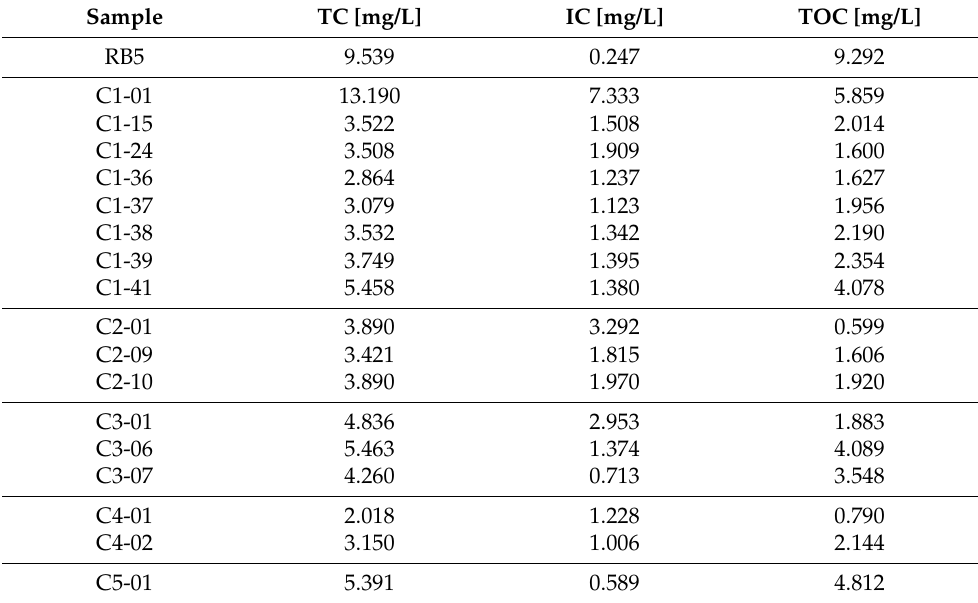
Table 5. TOC, IC, and TC of permeate in the adsorption columns after different cycles. Cx-yy: x is the name of the column, and yy is the number of cycles.